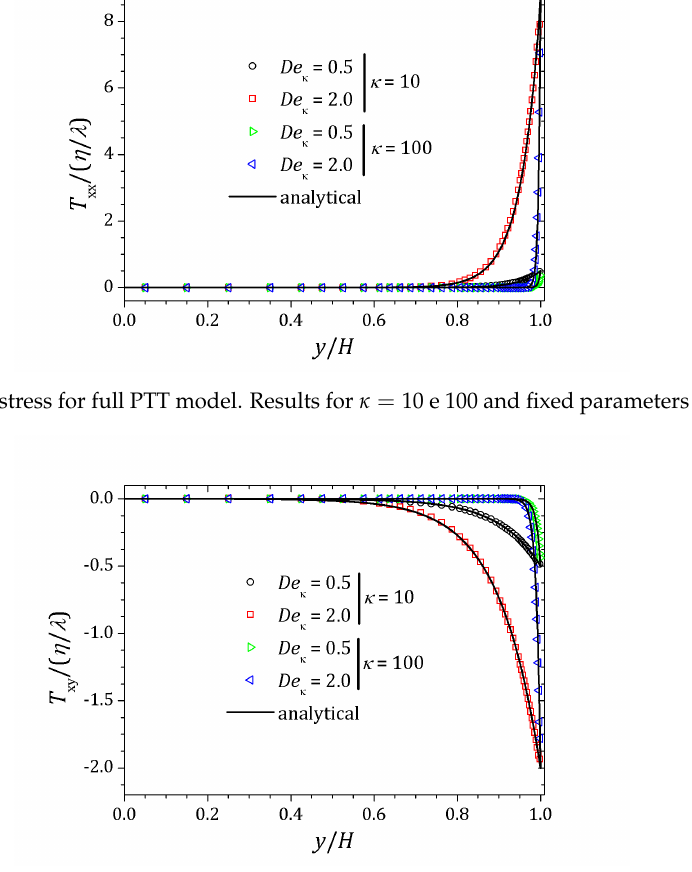
Figure 10. Shear stress for full PTT model. Results for κ = 10 e 100 and fixed parameters ε = ξ =